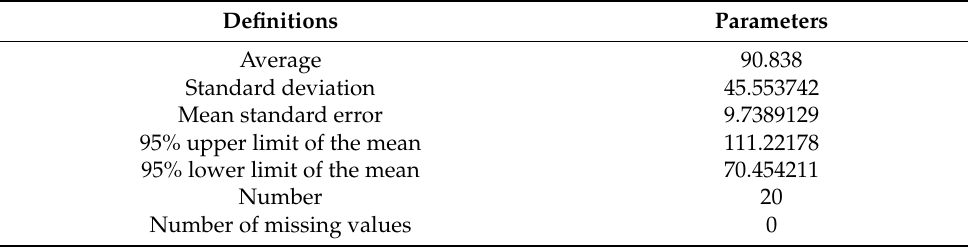
Table 6. Summary statistics.